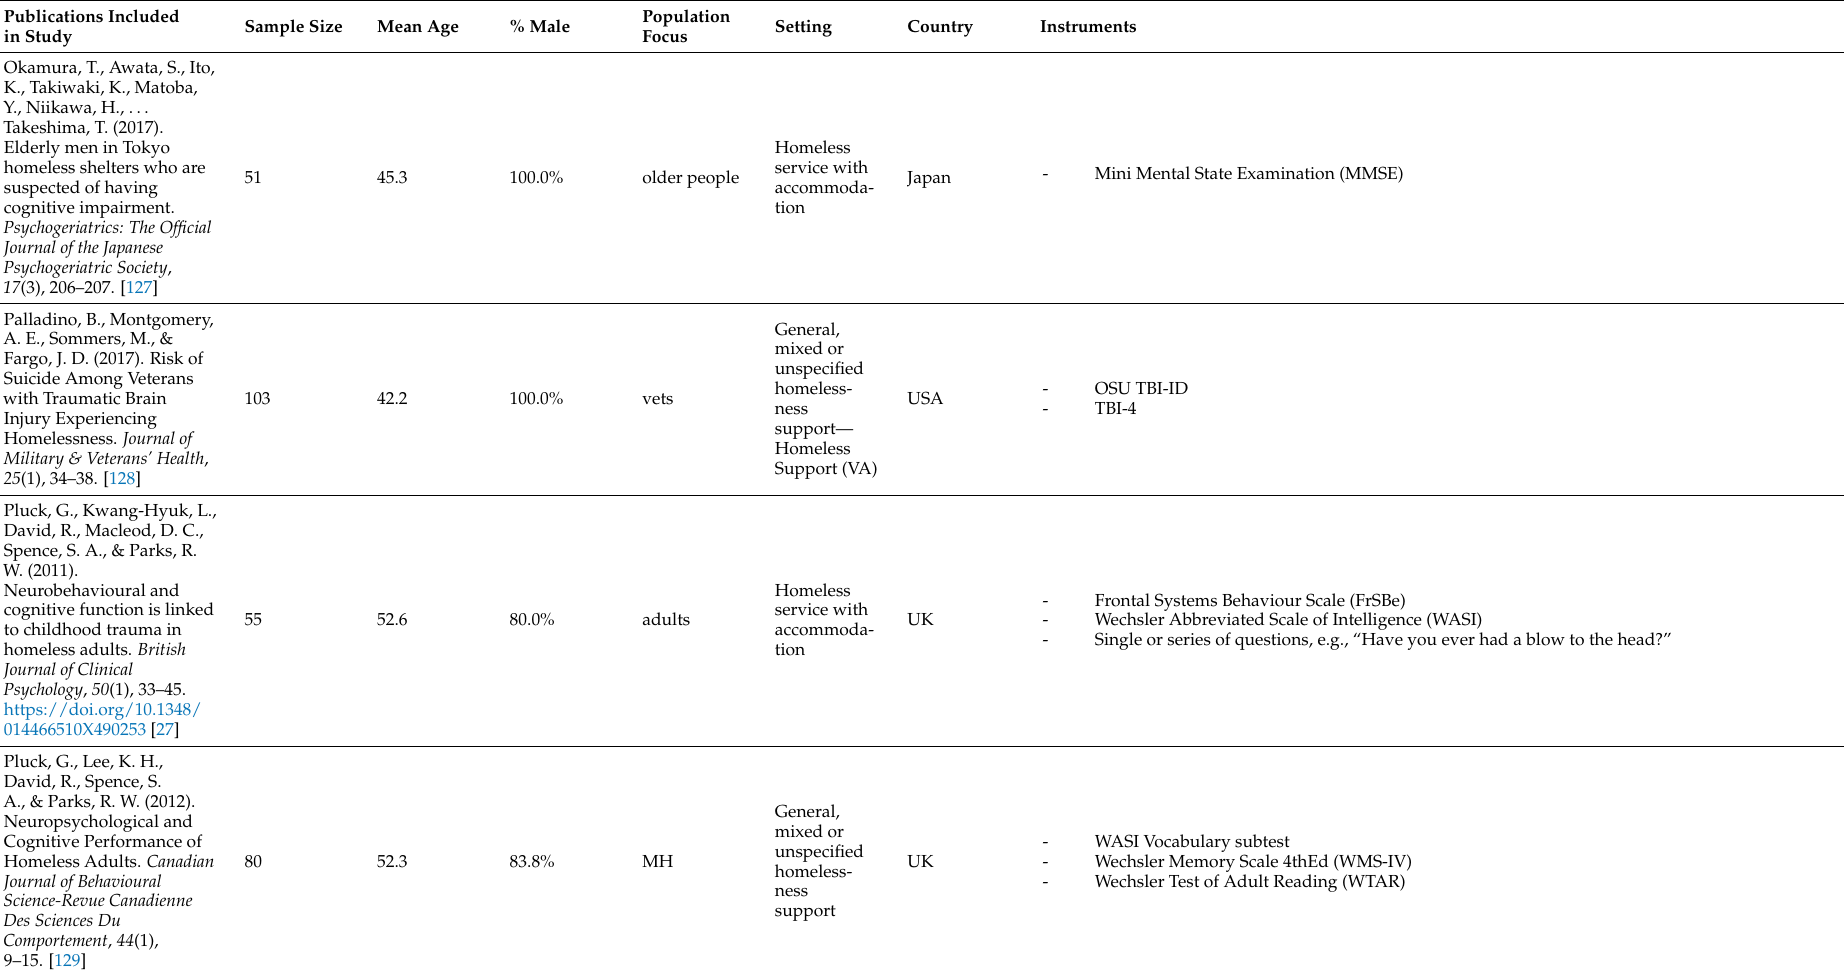
Setting Country Instruments